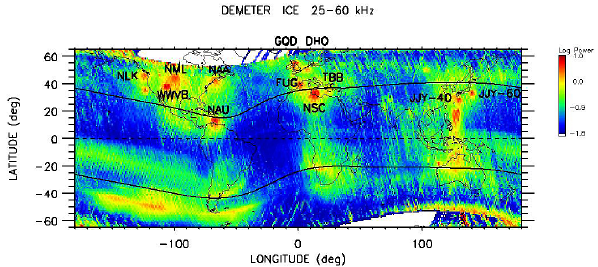
Fig. 8. Average distribution of electric power in the 25–60kHz range measured during night passes during 3yr. The correspond- ing transmitters are indicated by their international code. The two black lines indicate the L = 1 . 5 contours in the Northern and the Southern hemispheres.